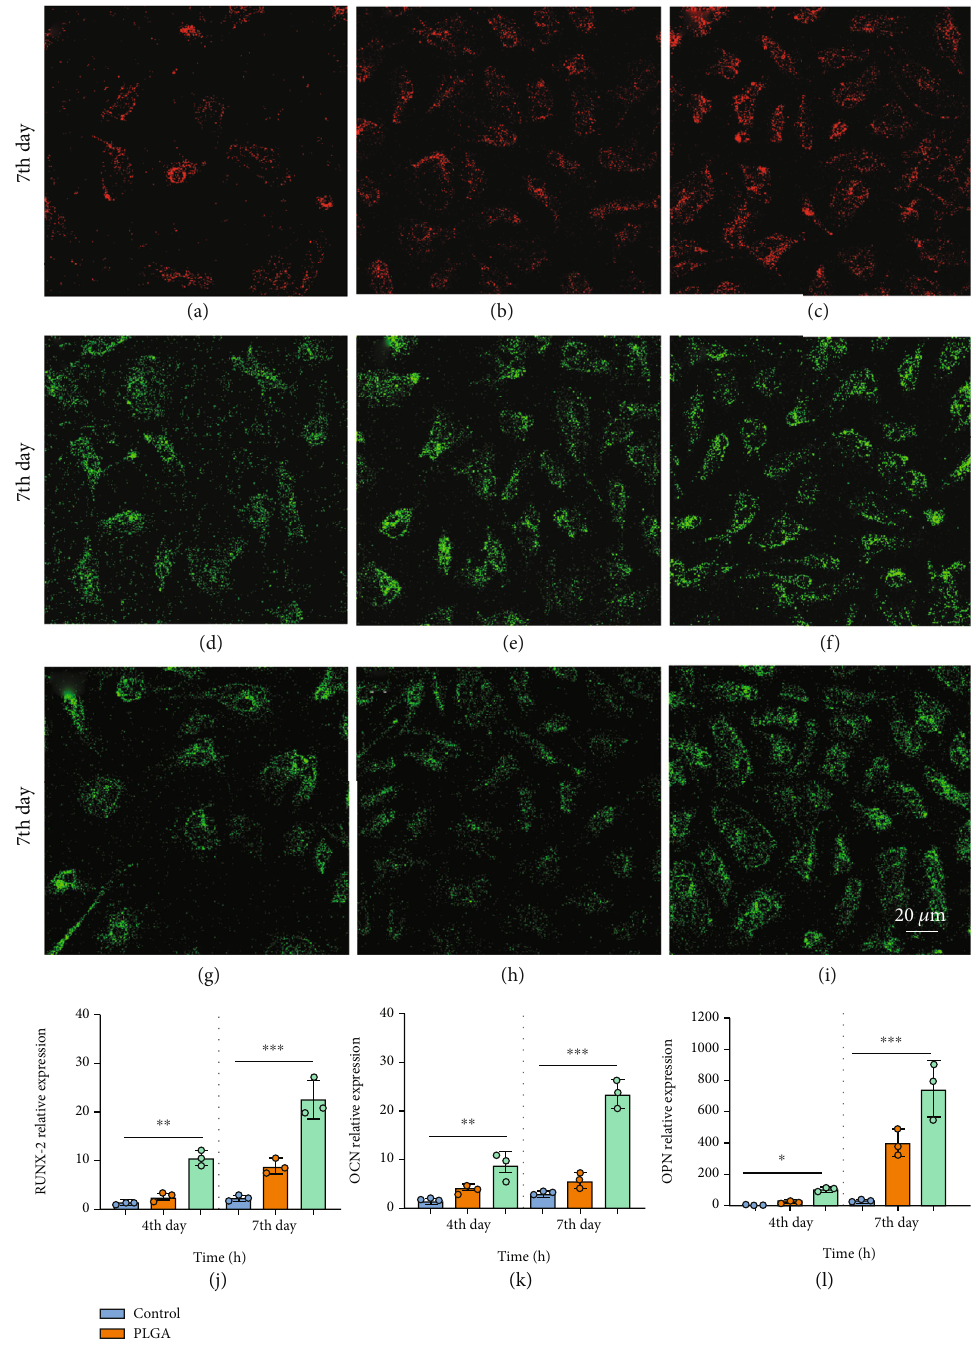
Figure 7: Detection of related osteogenic genes. (a – c) RUNX-2 fl uorescent staining results of control, PLGA, and Chi-MSN groups. (d – f) OCN fl uorescent staining results of control, PLGA, and Chi-MSN groups. (g – i) OPN fl uorescent staining results of control, PLGA, and Chi- MSN groups. (j, k) Quantitative evaluation of RUNX2, OCN, and OPN relative expression in control, PLGA, and Chi-MSN groups. ∗∗ P < 0 : 01 and ∗∗∗ P < 0 : 001 vs. control or PLGA